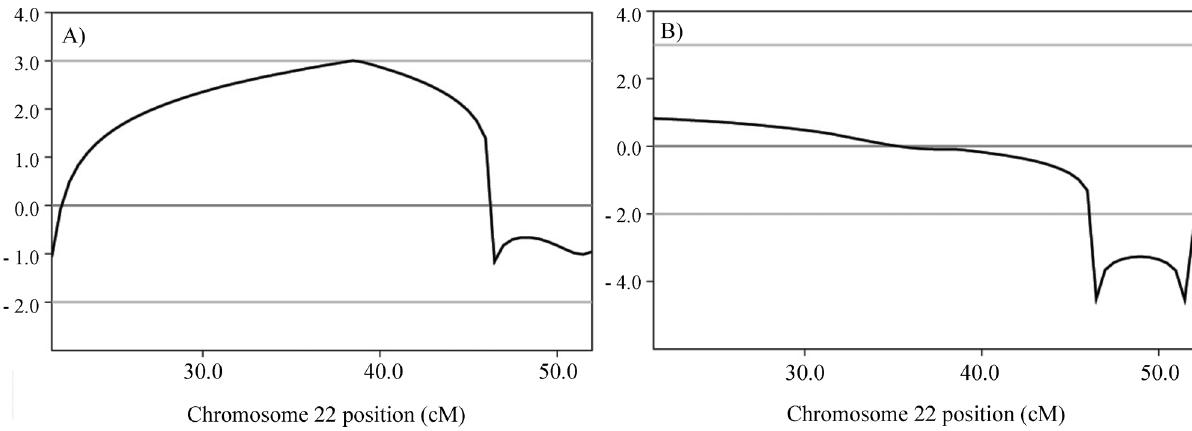
Figure 6 - Multipoint Lod Scores (on the Y-axis) obtained with microsatellite data for chromosome 22. A) Individuals marked with ? in Figure 5 were considered as unaffected in this calculation; B) Individuals marked with ? in Figure 5 were considered affected by the same genetic disorder in this calcu-